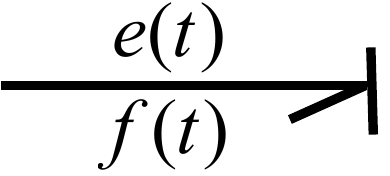
Figure 4. Causal